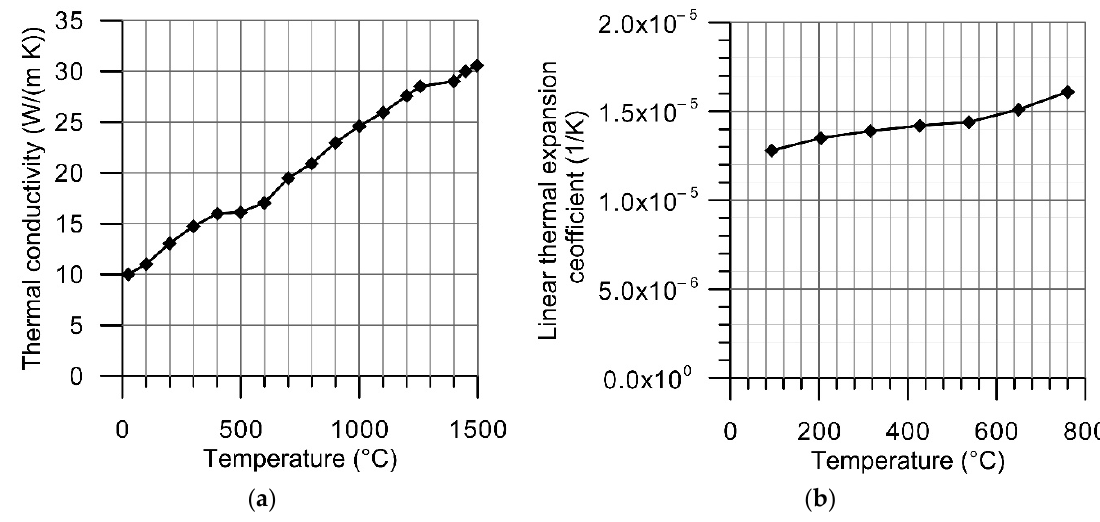
Figure 5. Thermal dependence of: ( a ) thermal conductivity [41], ( b ) linear thermal expansion coefficient [42].